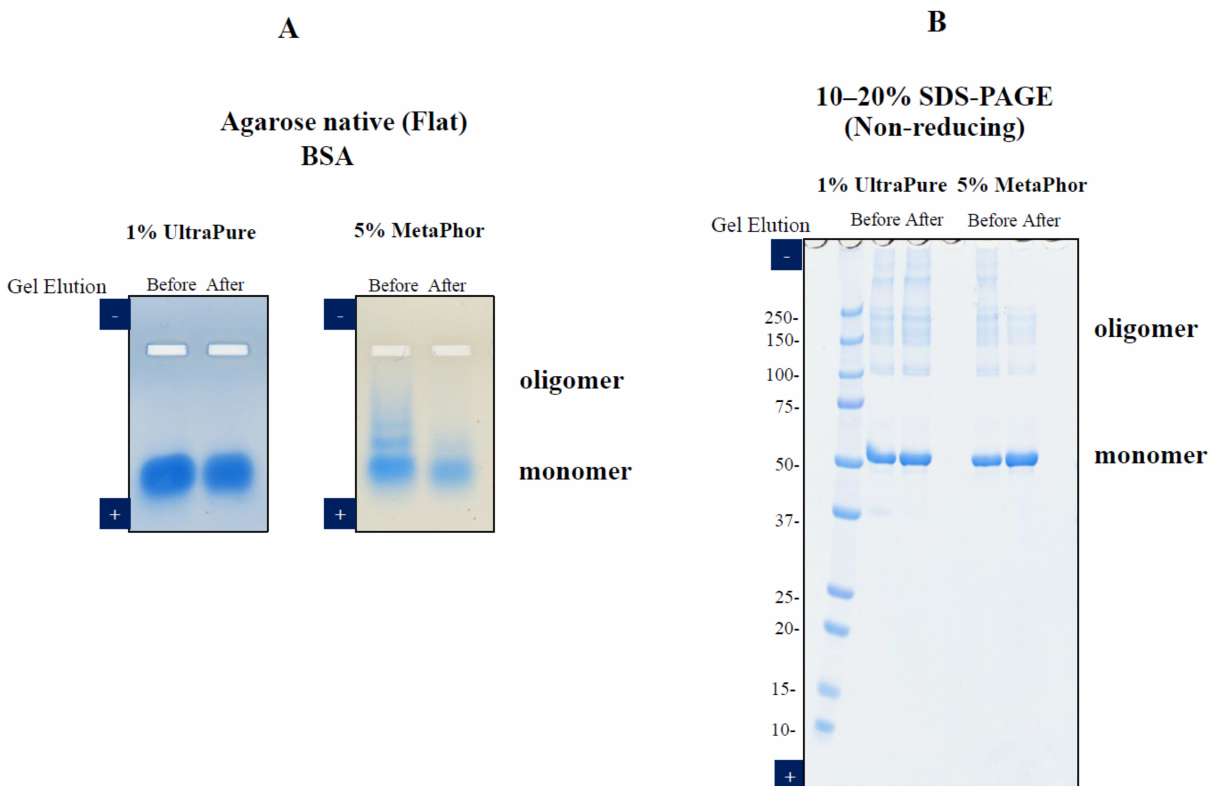
Figure 2. Electrophoresis of BSA before and after gel elution. BSA (2 µ g/lane) before and after gel elution were analyzed using two different electrophoresis methods. First: ( A ) agarose native gel electrophoresis. Left panel: BSA sample before and after extraction from 1% UltraPure agarose. Electrophoresis was performed with 1% UltraPure agarose at 100 V for 50 min. Right panel: BSA sample before and after extraction from 5% MetaPhor agarose. Electrophoresis was performed with 5% MetaPhor agarose at 100 V for 90 min. ( B ) 10–20% SDS-PAGE under non-reducing conditions, BSA sample before and after extraction from 1% UltraPure agarose or 5% MetaPhor agarose.